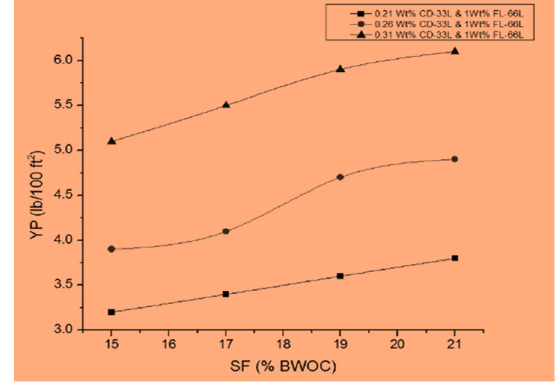
FIG. 7. COMBINED ADDITIVE EFFECTS ON YP OF 13